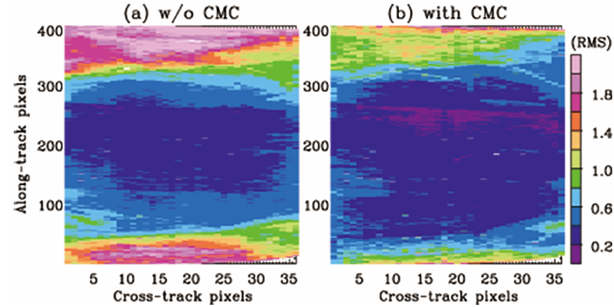
Figure 11. Same as Fig. 10 but for root mean square (rms) of fitting residuals relative to the measurement errors as functions of along- and cross-track pixels. The rms is defined as that OMI noise floor errors (0.4% at wavelengths <310nm and 0.2% at wavelengths >310nm) are used to define